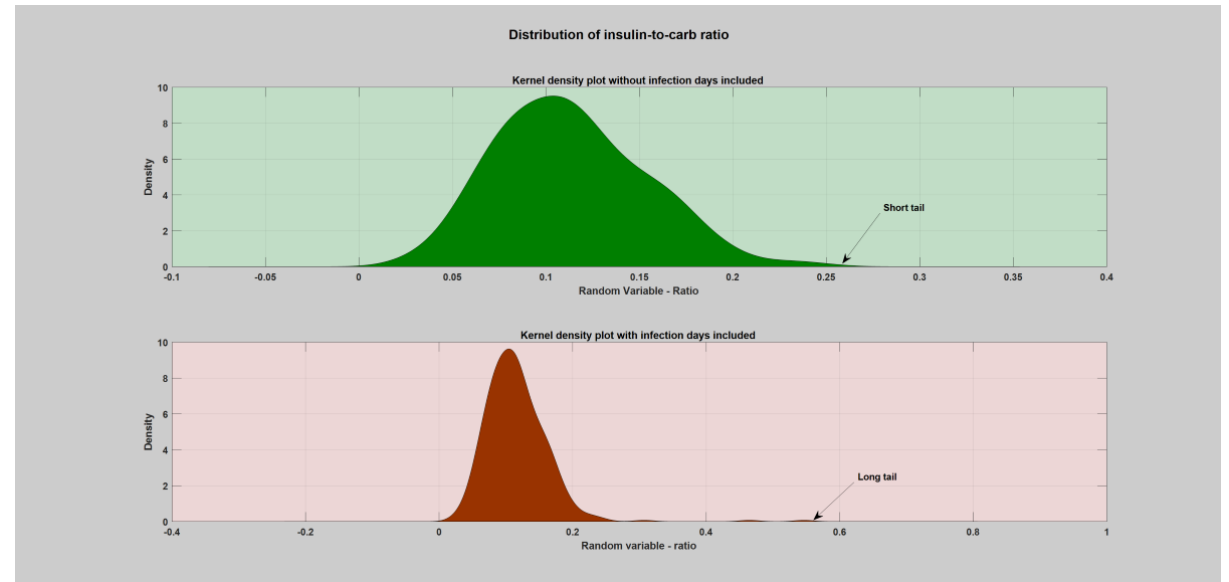
Figure 12. Univariate kernel density estimation of a patient year using the daily insulin-to-carbohydrate ratio. As can be seen from the tail of the distribution, during regular or normal days (the green shaded region), the yearly distribution of the patient’s insulin-to-carbohydrate ratio lies within the values of 0.005 and 0.2. However, during infection incidence (the red shaded region), there is a clear deviation in the tail of the distribution, where the values reaches around 0.58.